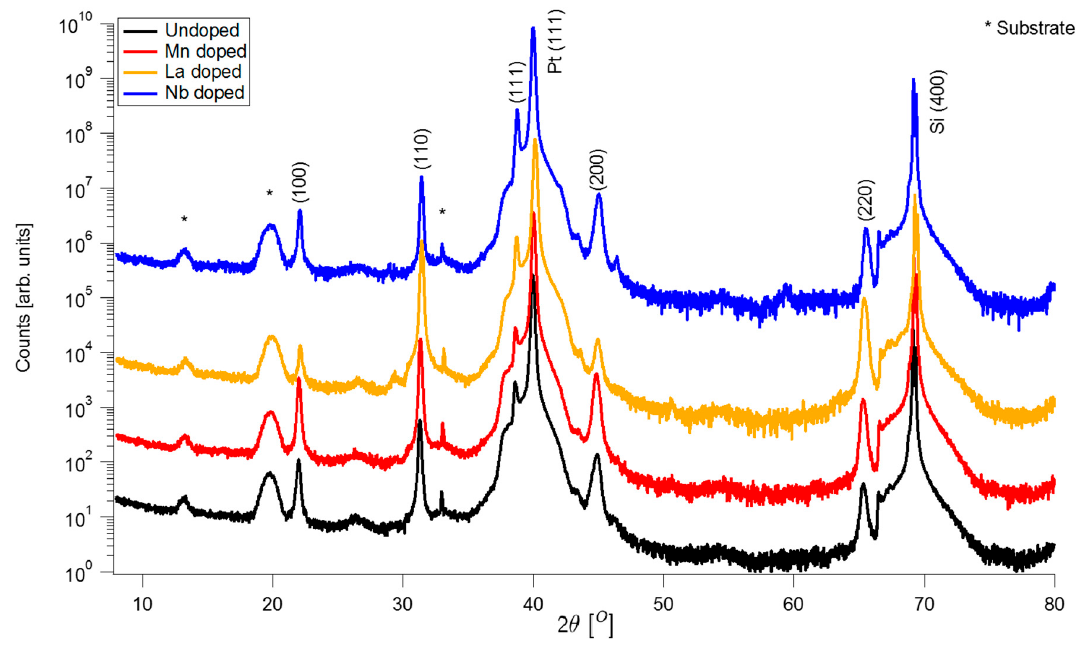
Figure 2. XRD diffraction patterns (2 theta) of (un)doped samples. Figure 2. XRD di ff raction patterns (2 theta) of (un)doped samples.